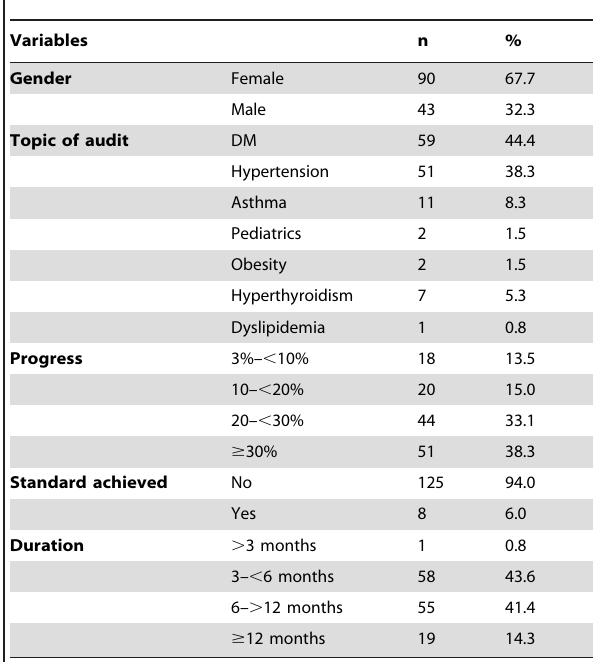
Table 1. General characteristics of the audits done (2004–